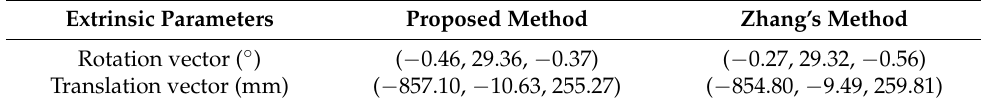
Table 2. Extrinsic parameters of the stereo vision system resulting from the two methods.